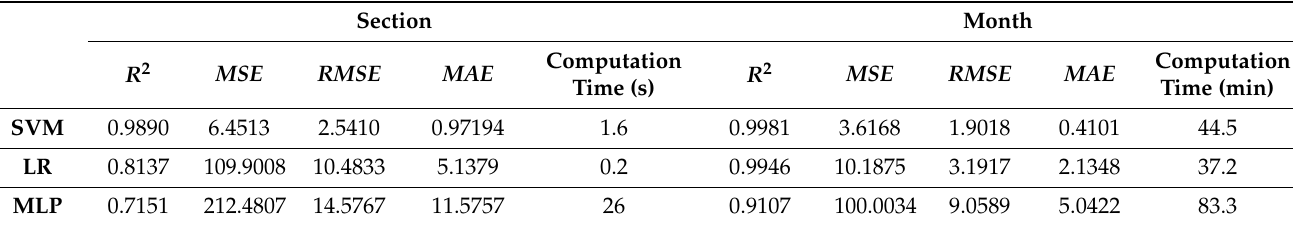
Figure 10. The prediction for the month event in SVR, LR, and MLP. 8. Conclusions This research focused on the ML prediction model for an in-vehicle air quality appli- cation. A hardware testbed was developed to obtain sensor data in the in-vehicle indoor environment. Then, three predictive models of machine learning algorithms such as LR, SVR, and MLP were applied to the in-vehicle air quality prediction system to predict the air quality inside the vehicle cabin. This allowed the monitoring of the real-time air quality inside the car cabin. The system can be used as a potential measure to reduce traffic acci-